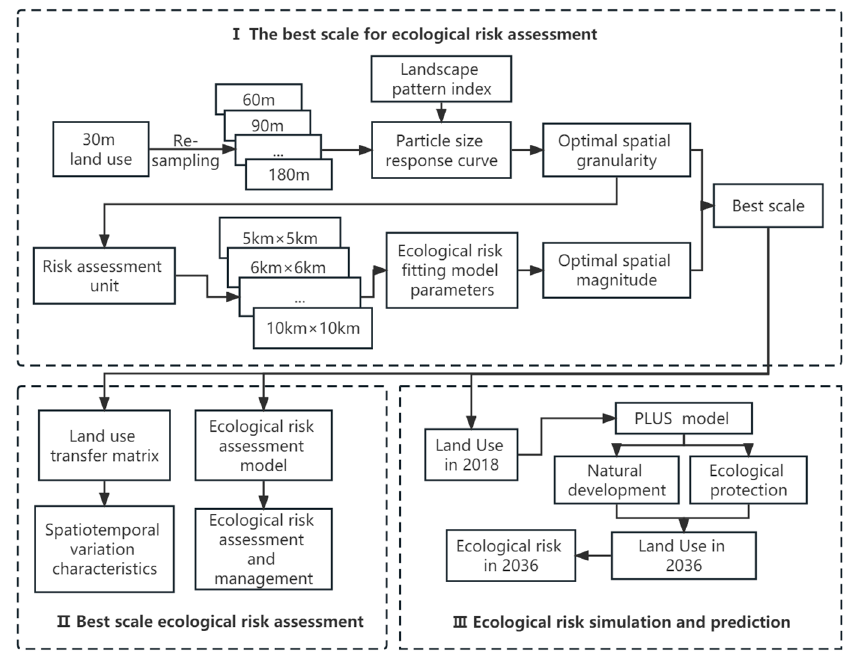
Figure 3. The framework of this